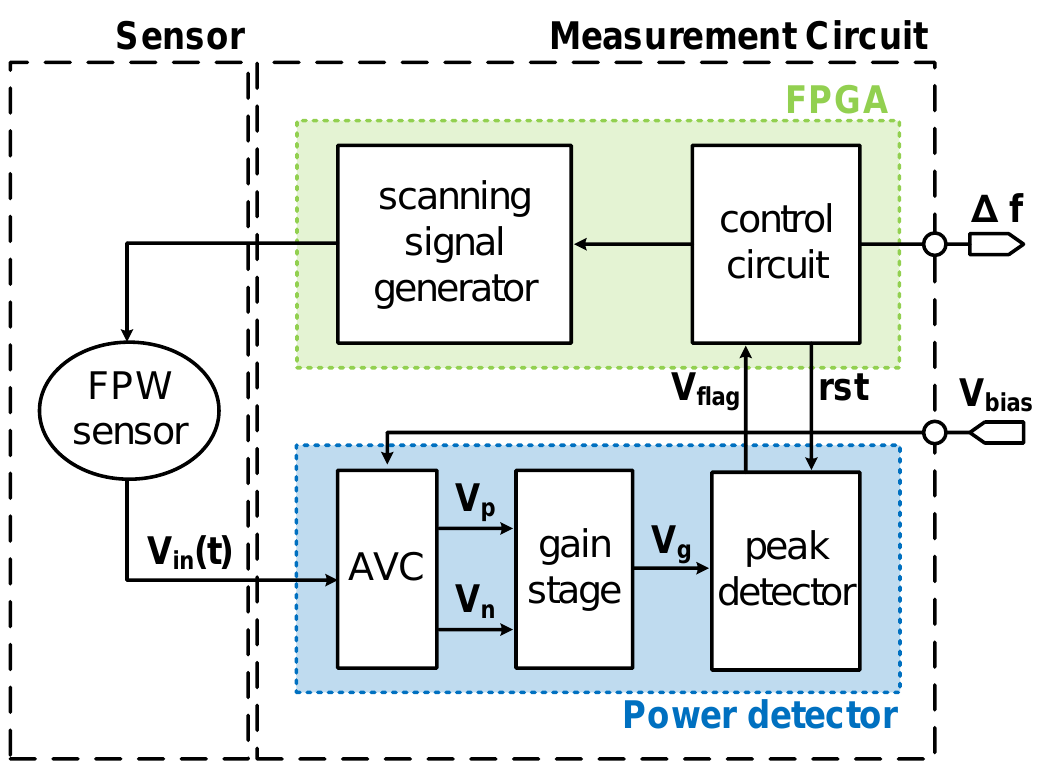
Figure 3. Block diagram of the FPW readout system.